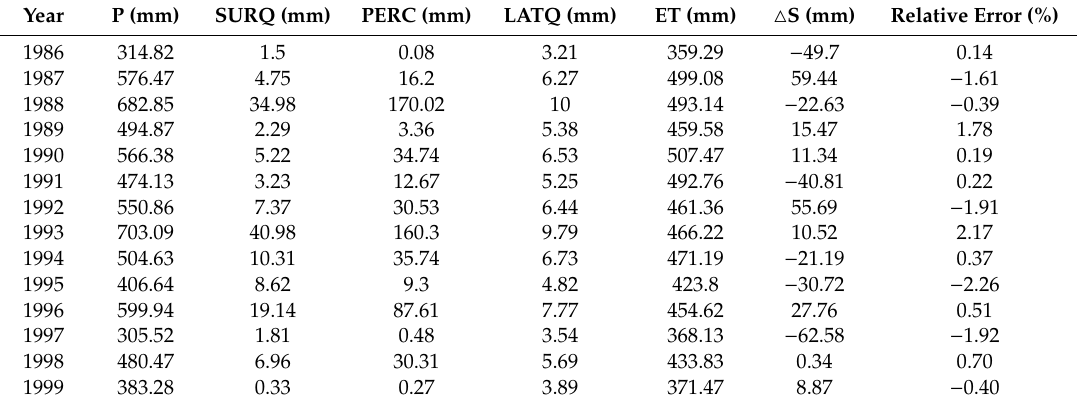
Figure 5. Xinshui River Watershed annual average water balance from 1986 to 1999. Table 5. Annual water balance components in Xinshui River Watershed, from 1986 to